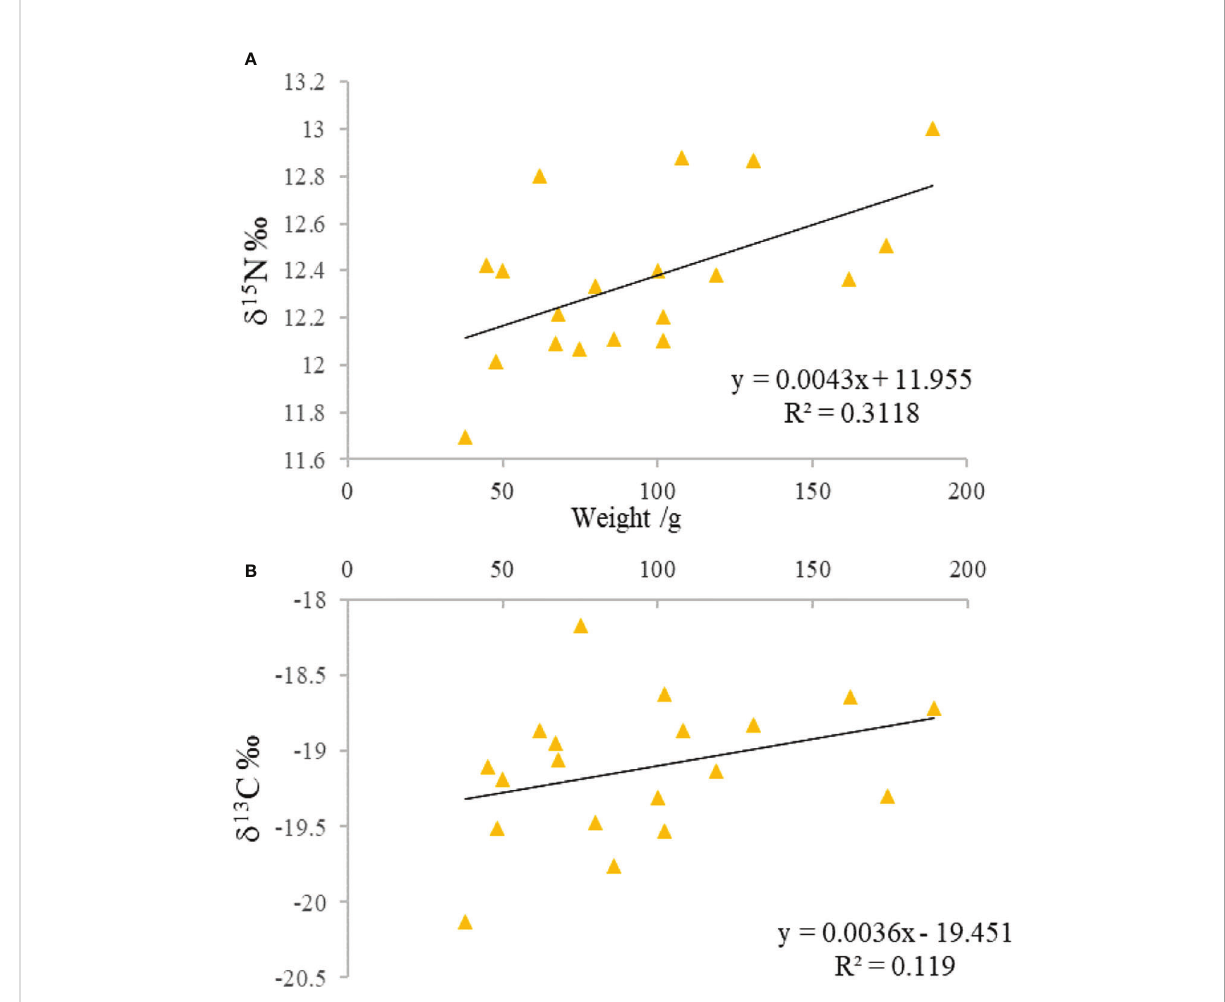
FIGURE 3 Relationship between d 15 N (A) and d 13 C (B) and body weight of M. senile